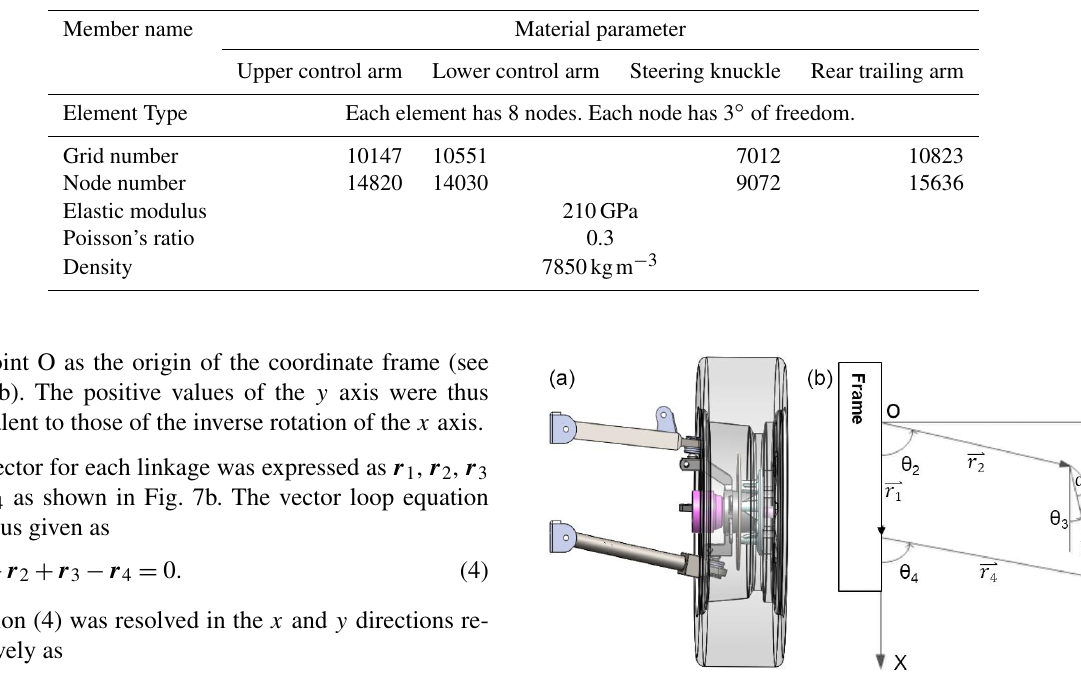
Table 4. Model construction details and material parameters for compliant members of front and rear suspensions.